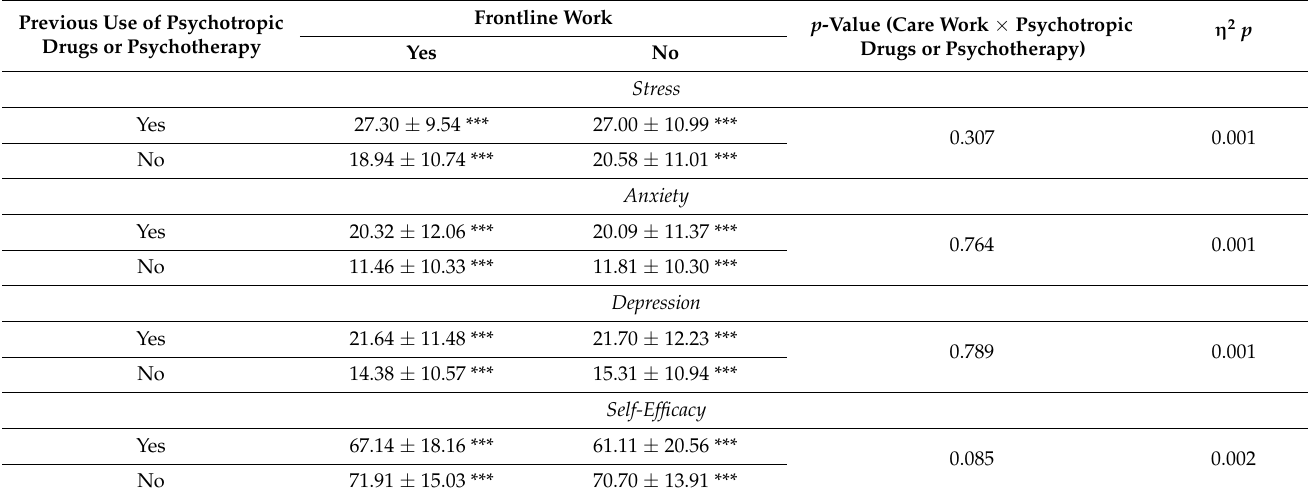
Table 5. Level of stress, anxiety, depression, and self-efficacy according to the type of work and previous use of psychotropic drugs or psychotherapy.